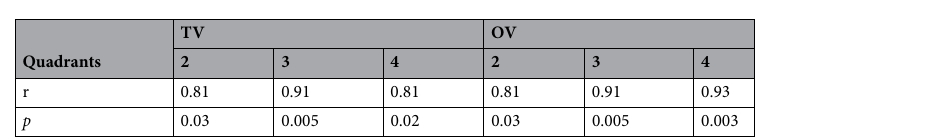
Figure 8. 3D representation of OA femoral head epiarticular osteophytes extended from peripheral marginal area to the surface of femoral head; ( A ) axial view and ( B ) coronal view.